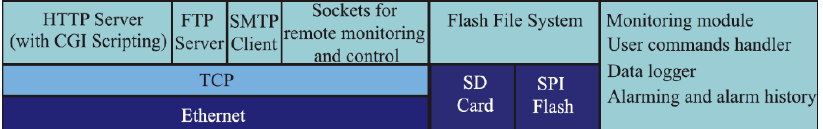
Figure 15. Functionalities of the Ethernet gateway module (HTTP-Hypertext Transfer Protocol, CGI- Common Gateway Interface, FTP-File Transfer Protocol, SMTP-Simple Mail Transfer Protocol, SPI-Serial Peripheral Interface, TCP-Transmission Control Protocol) [15].